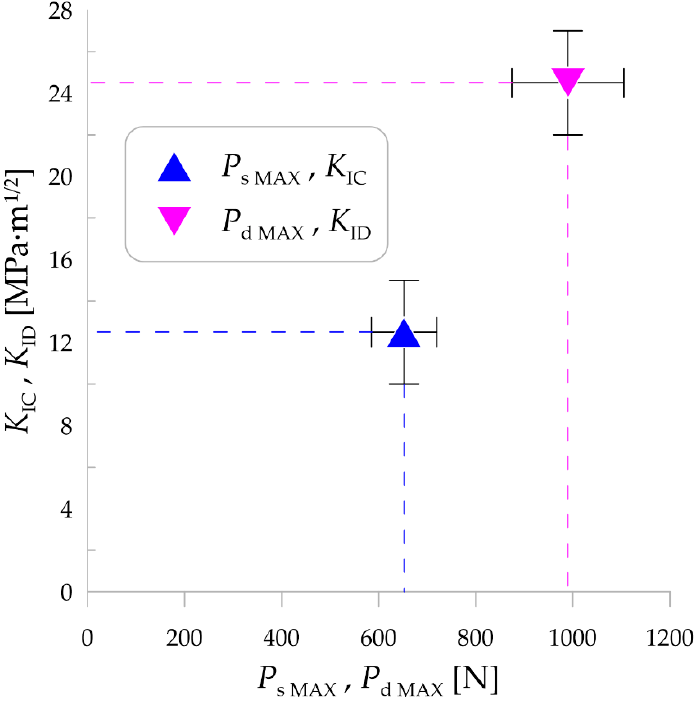
Figure 5. Mean values of static and dynamic fracture toughness ( K IC and K ID , respectively) versus static and dynamic force ( P s and P d , respectively).